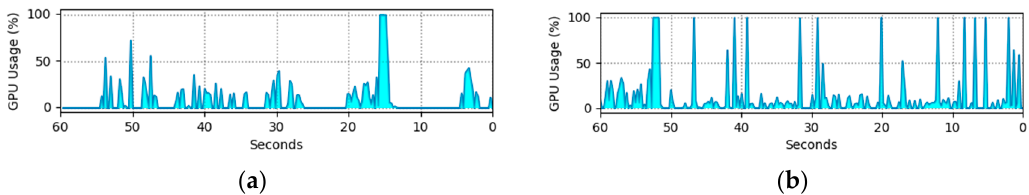
detection. detection.